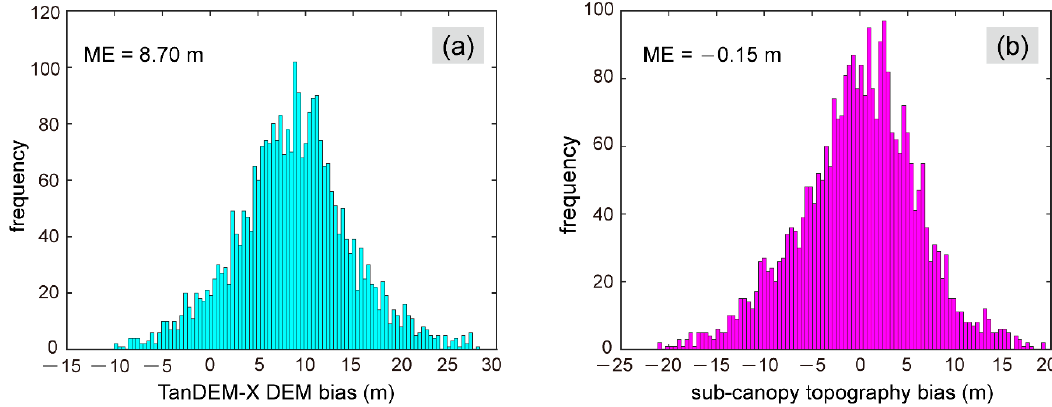
Figure 10. Histograms of the elevation bias: ( a ) Original TanDEM-X DEM; ( b ) Sub-canopy topography.